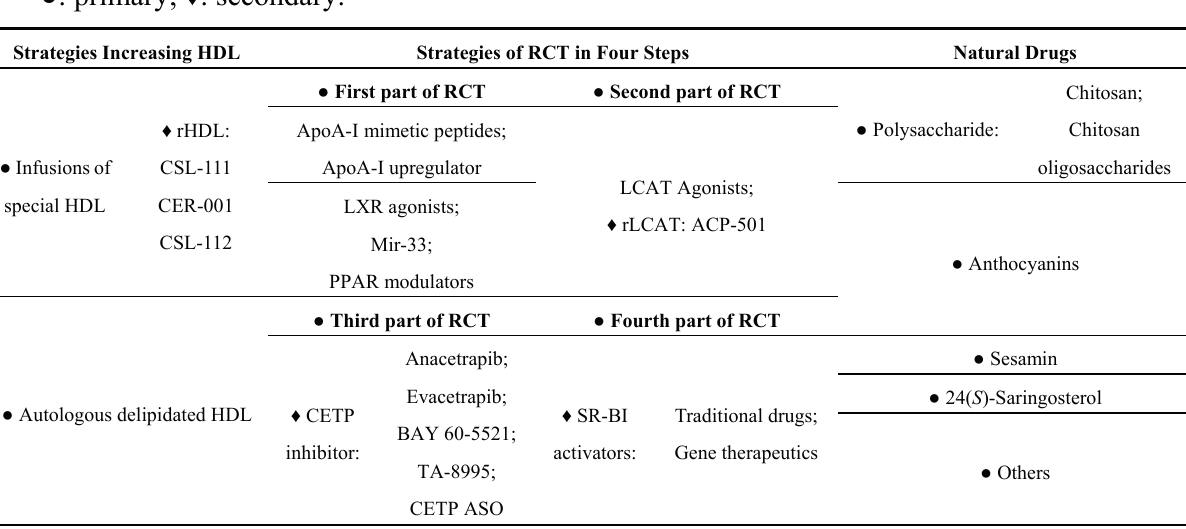
Table 2. Overview of Classes of HDL-based therapies. HDL-based therapies are an innovative approach against atherosclerosis. In this review, they can be summarized as the following three categories: strategies increasing HDL, strategies of RCT in four steps and natural